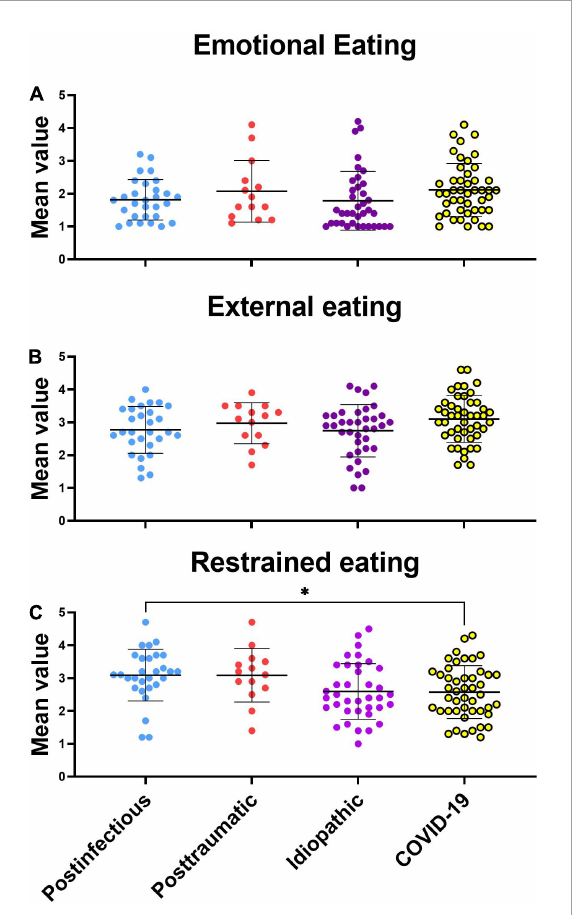
FIGURE1 Scattergram (mean ± SD) of the Dutch eating behavior questionnaire by different eating styles. Groups were compared by the ANOVA test with post hoc Tukey’s test. ∗ P <